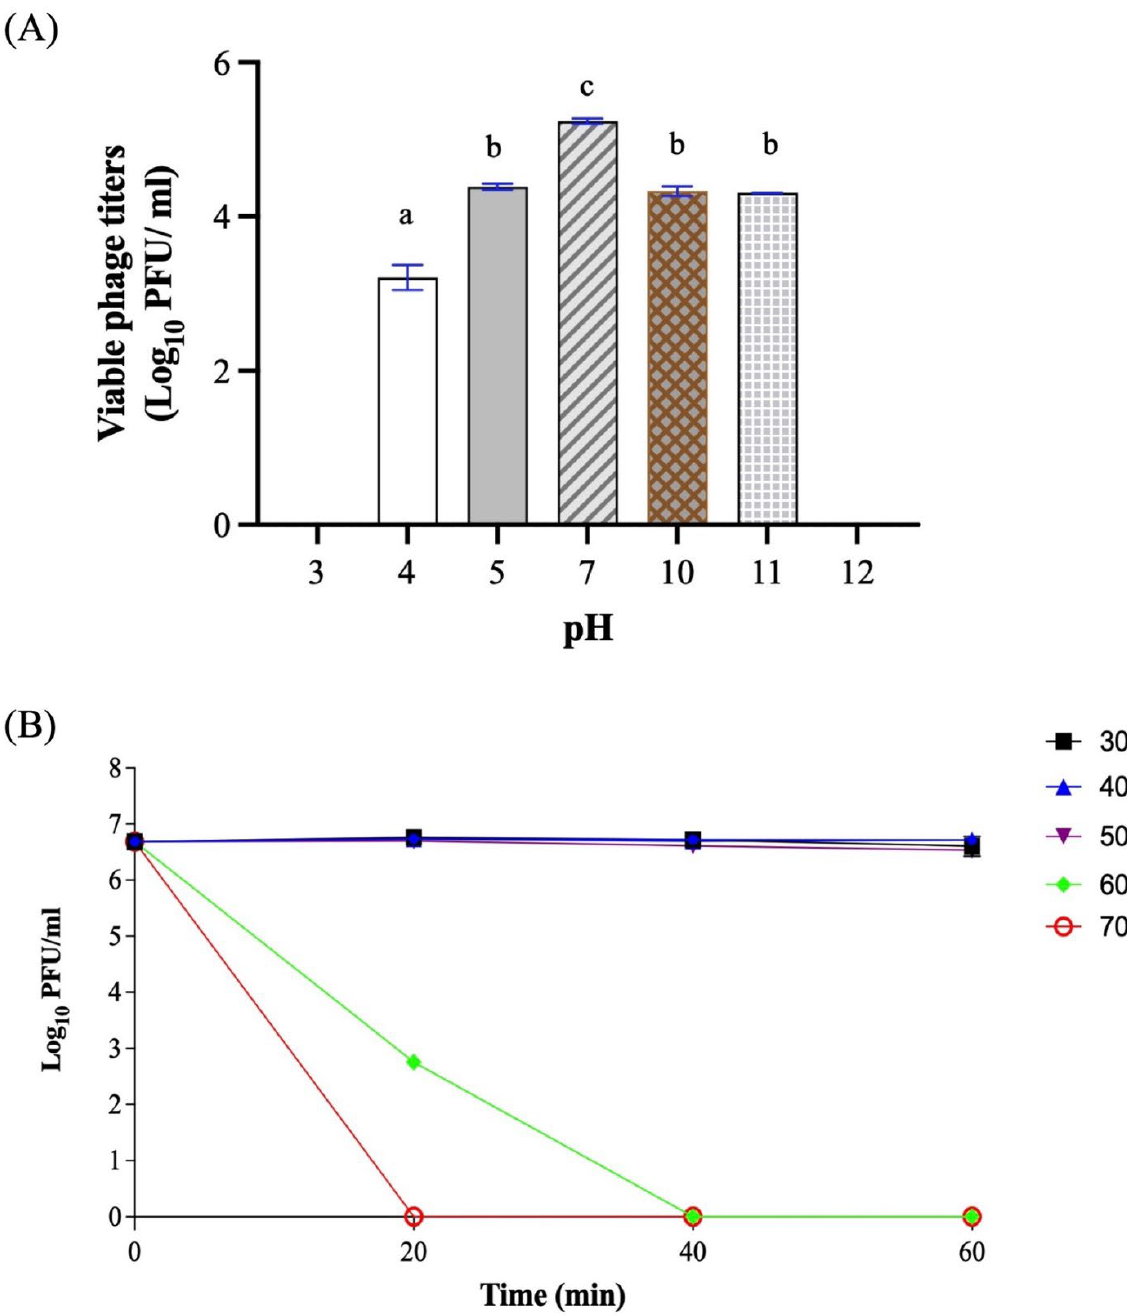
Figure 6. Stability of phage Ro45lw at ( A ) different pH levels (pH 3, pH 5, pH 7.5, pH 9, pH 10.5, and pH 12) at 37 °C for 20 h, and ( B ) various temperatures (30 °C to 70 °C) for up to 1 h. For the pH test, the means of phage titers that lack common letters (a, b, and c) differ ( p < 0.05). The error bars show the SEM.